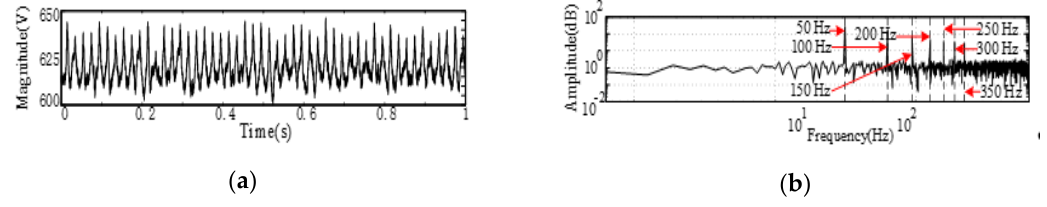
Figure 24. Waveforms of input signal with noise: ( a ) magnitude, ( b ) spectrum.